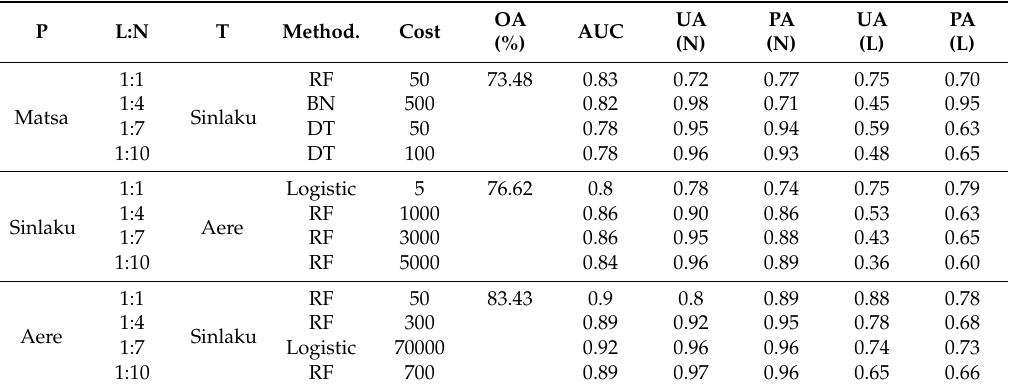
Table 5. Best results of the event-based landslide susceptibility